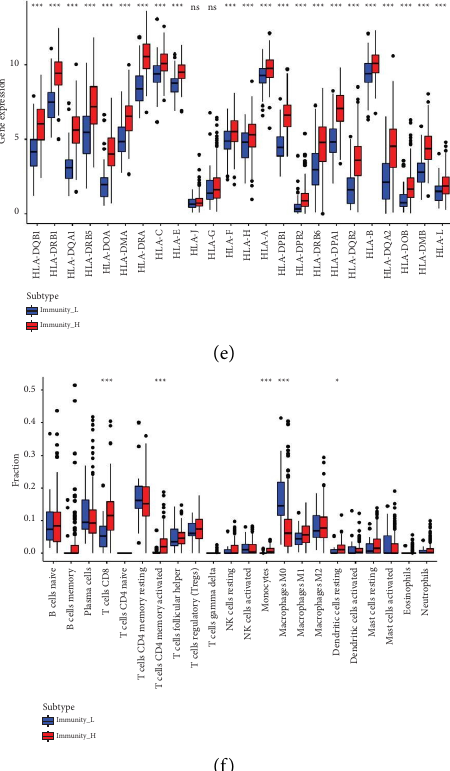
Figure 1: (a) Te PCA analysis reveals the diferent immune subtypes of GC cohort; (b) the diferent immune subtypes were divided by ssGSEA algorithm; (c) the diferent immune cell infltration between Immunity_L and Immunity_H subtype; (d) the stromal score, immune score, and estimate score between Immunity_L and Immunity_H subtype; (e) the expression level of HLA encoding genes between Immunity_L and Immunity_H subtype; (f) the immune cells analysis between Immunity_L and Immunity_H